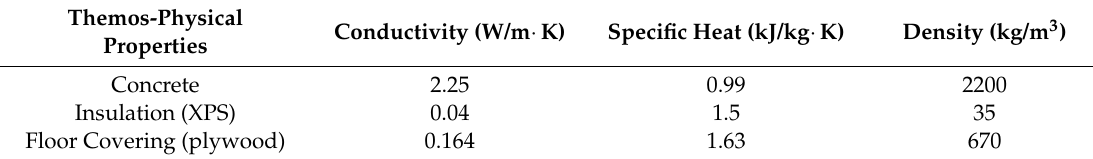
Figure 5. Electric floor heating system—reference case. Table 2. Floor layers thermos-physical properties.